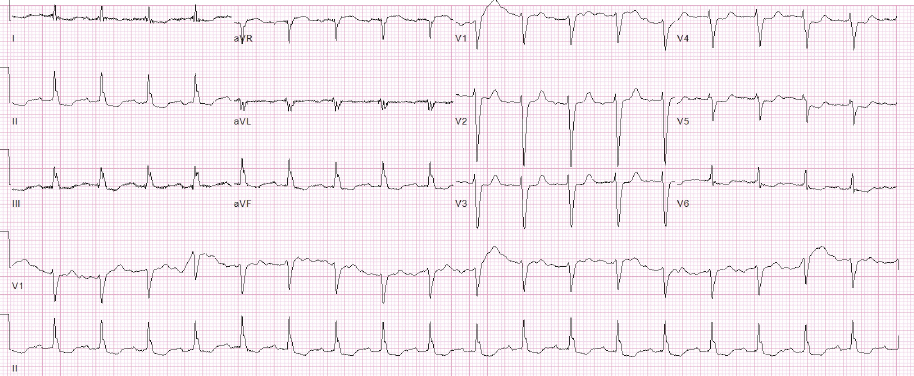
Figure 1: EKG on presentation reveals normal sinus rhythm with heart rate of 108bpm.